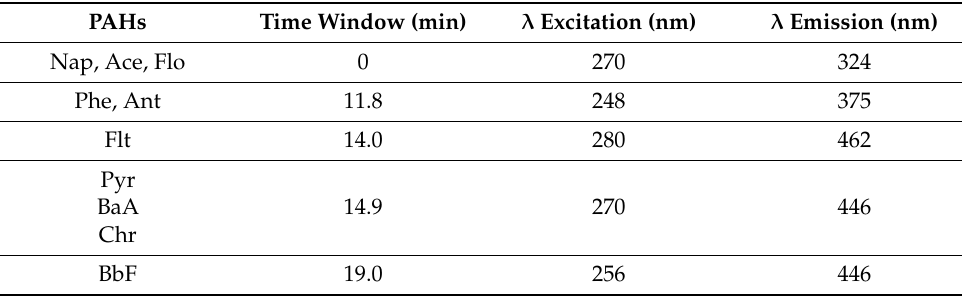
Table 1. Fluorescence detection settings for the determination of